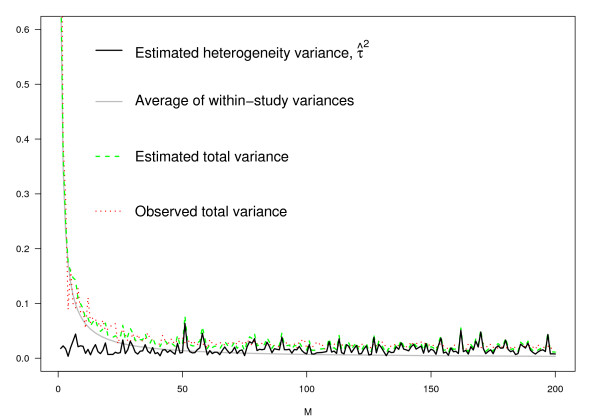
Within-study variation, decreasing with increasing sample size while heterogeneity remains constant. Details in text.